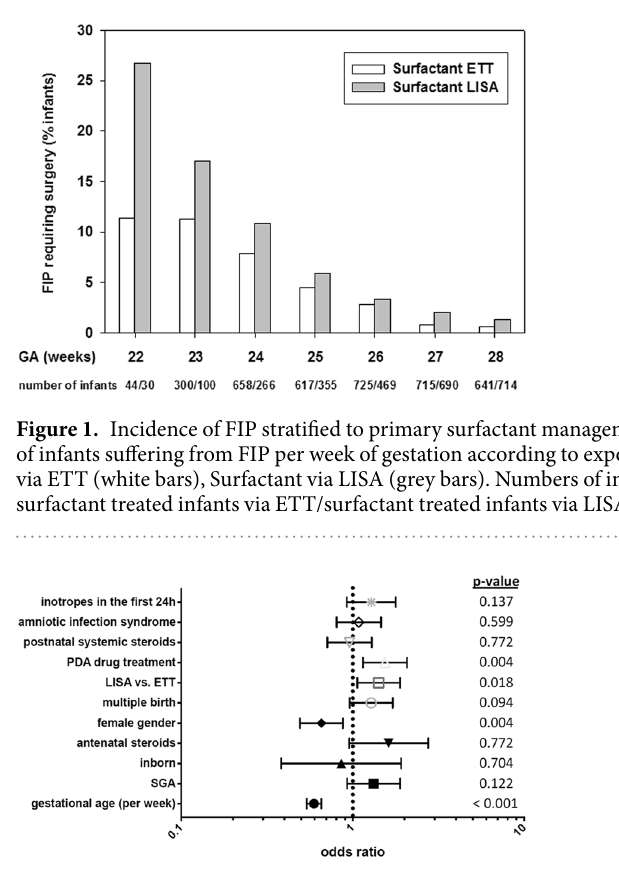
Figure 2. FIP requiring surgery – logistic regression model. The figure depicts the data of a multivariable logistic regression model to adjust the effect of LISA strategy for known or probable confounding variables including inotropes in the first 24 hours (surrogate marker for severity of primary compromise at birth), amniotic infection syndrome as cause of preterm birth, postnatal steroid hormones (dexamethasone, hydrocortisone, (methyl)prednisolone), PDA drug treatment (indomethacin, ibuprofen), multiple birth, female gender, antenatal steroids, inborn, SGA, gestational age per week. The symbols and lines describe the odds ratios and 95% confidence